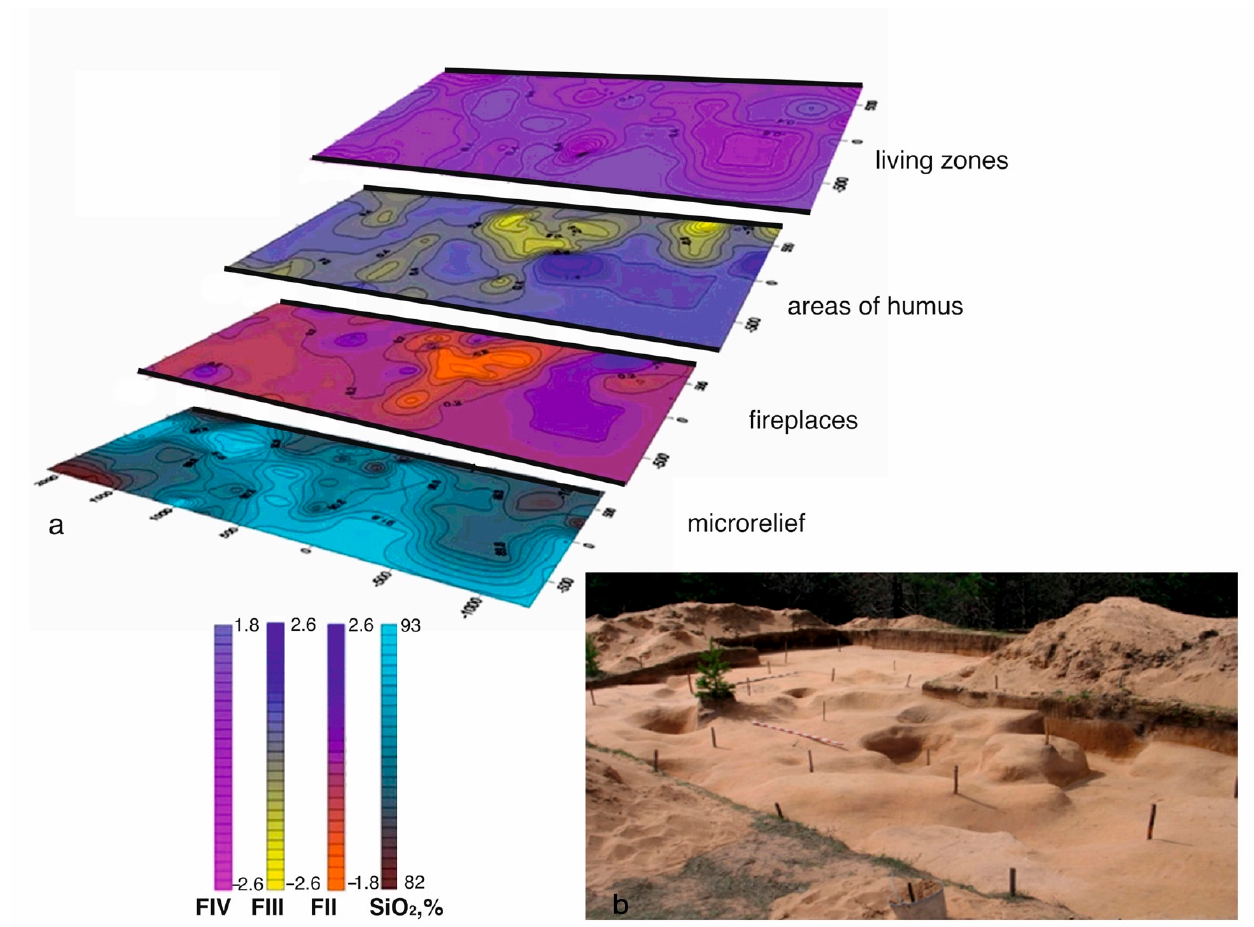
Figure 3. ( a ) Spatial distribution of functional zones on the surface of the 1st cultural horizon of the Serteya 3-3 site according to geochemical mapping adapted from [37]; ( b ) surface of the 1st cultural layer [37], designed by M.Kulkova.